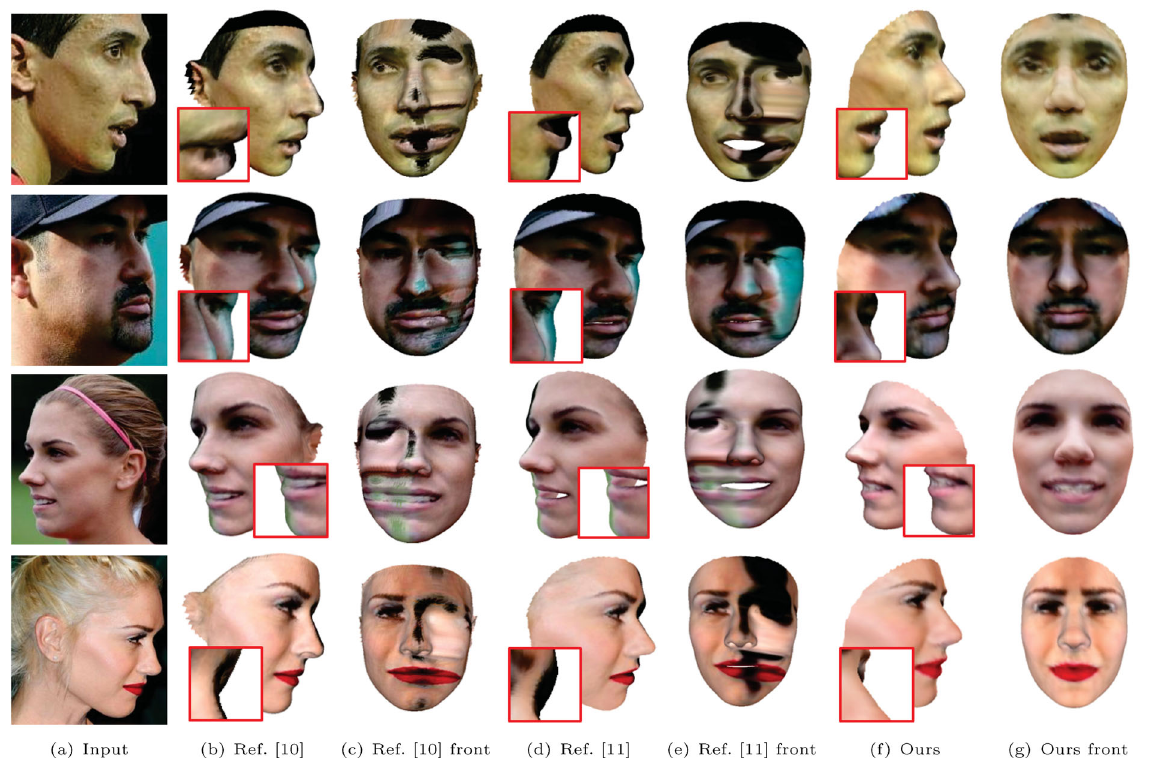
Fig. 5 Qualitative texture mapping comparison between our method, PRNet, and Deep3DFace, showing side and frontal views of textured 3D faces. PRNet and Deep3DFace both leave artifacts in the texture of visible vertices, which cannot removed by post-processing algorithms. Table 3 Evaluation of our algorithm using the CFP dataset with frontal profile setting. Lower equal error rate (EER) is better